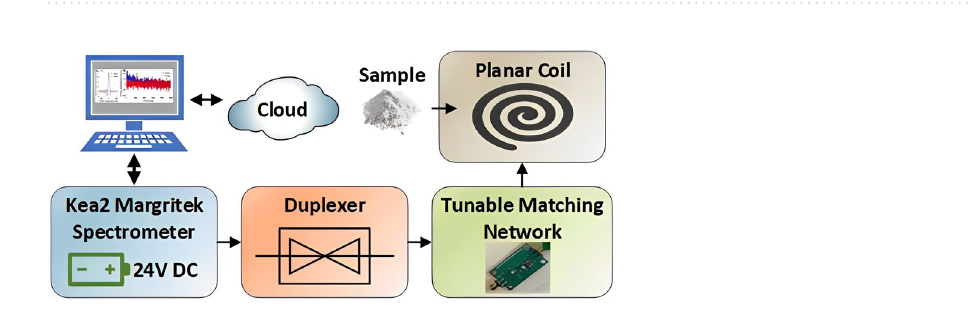
Figure 4. Psychoactive drug (a benzocaine sample) placed in various types of mail packaging for testing using a planar coil with an external matching network: ( a ) plastic bag, and ( b ) paper envelope. All are encased inside a aluminium Faraday